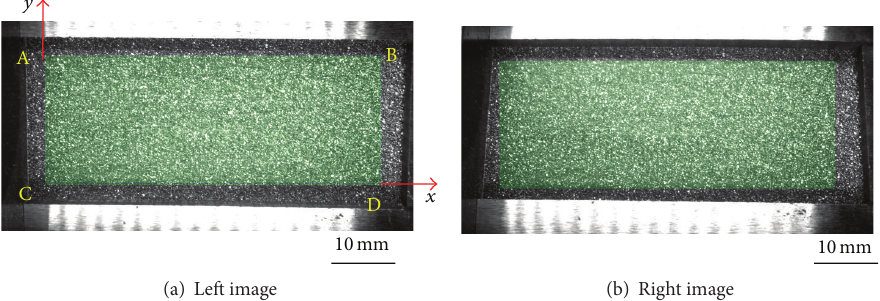
Figure 3: A pair of images of specimen surface captured by the two